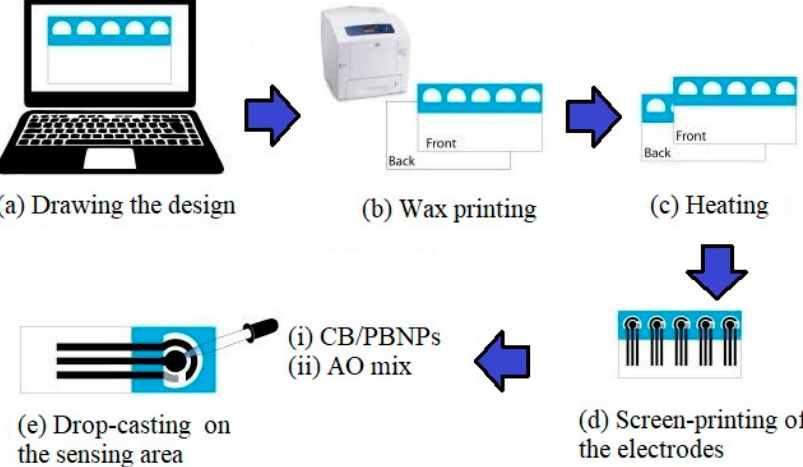
Figure 4. Schematic diagram of the fabrication steps of the paper-based nanomodified sensors [128] .